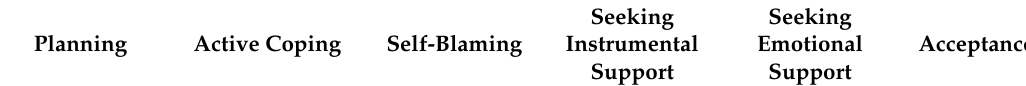
Table A3. Levels of statistical significance for post hoc pairwise comparisons of stress-coping strate- gies chosen in population presenting sleep bruxism